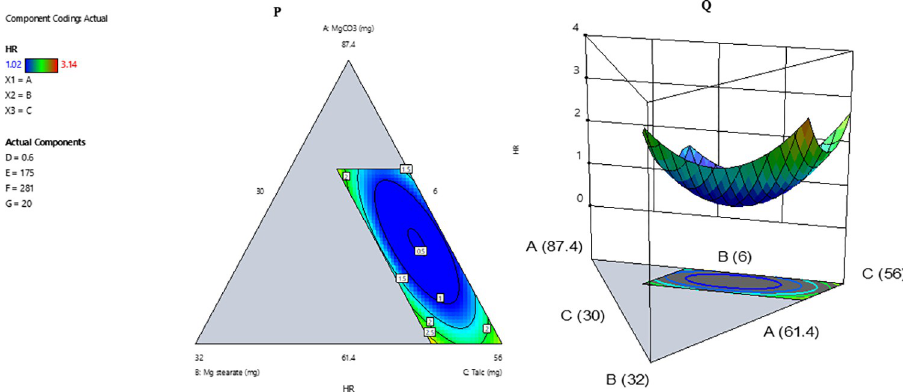
Fig 2. Model contour presentation. The contour diagram (P) and the 3D diagram (Q) represent three-component systems. It shows the relationships between the levels of the independent variables (magnesium carbonate (A), magnesium stearate (B), and talc (C) at a fixed level of sodium bicarbonate (G) of 20 mg, Sodium benzoate (D) of 0.6 mg, and 76% of active pharmaceutical ingredients (E = MCFE and F = AEFE) on flowability as measured by Hausner’s ratio (HR). Each tip of the triangle indicates each independent variable’s maximum level, whereas the three lines (AB, BC, CA) represent a binary mixture with the third variable kept on a fixed level in the center of the line. The blue- colored space indicates the combinations where the best desirable flowability can be achieved. The decrease in the amount of A and B increases flowability (low HR), with further decrease, leading to a decrease in flowability (high